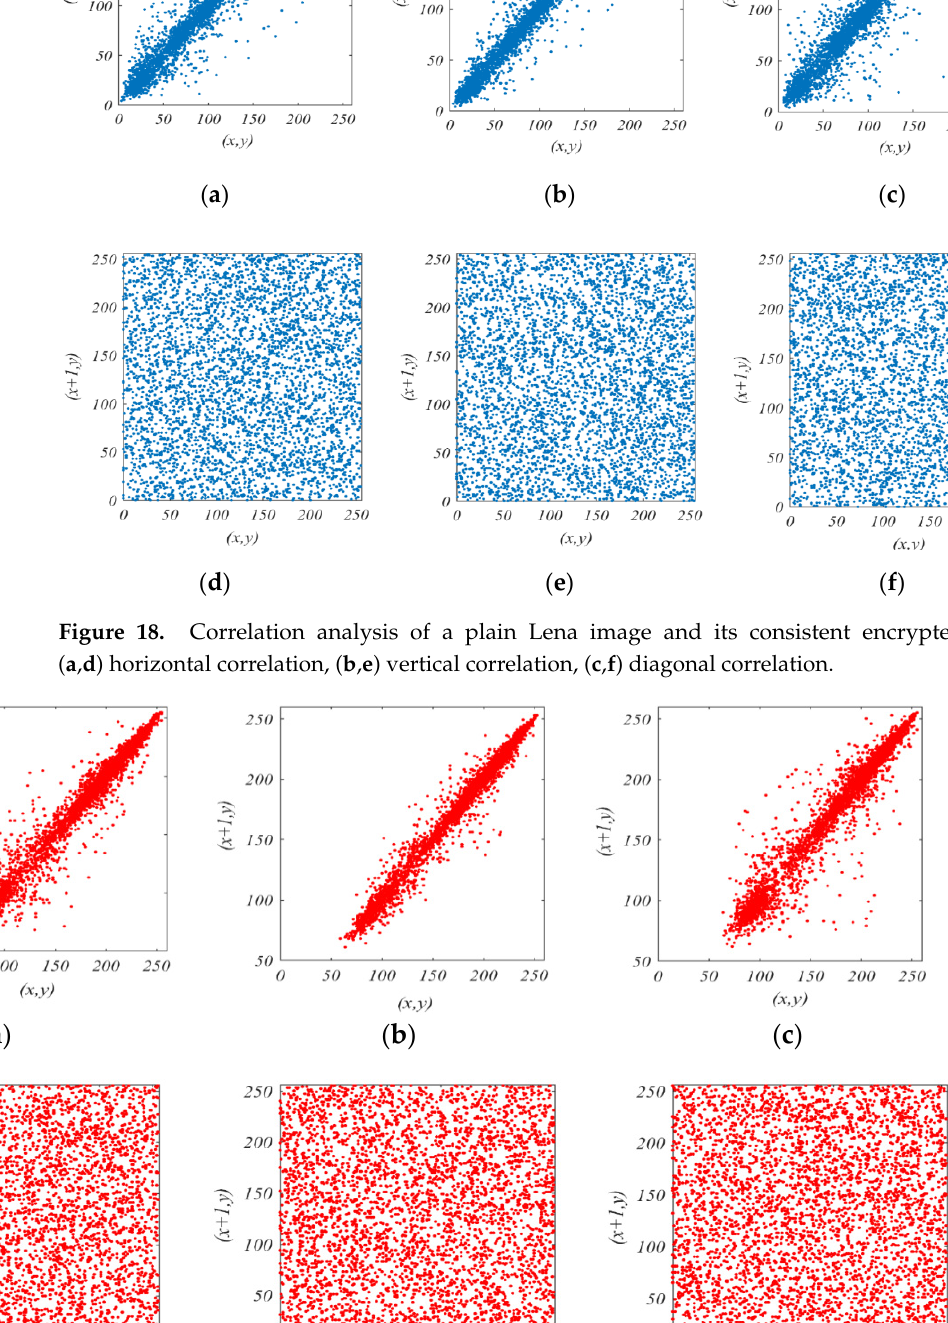
Figure 19. Correlation analysis of the R band of a plain Lena image and its consistent encrypted image: ( a , d ) horizontal correlation, ( b , e ) vertical correlation, ( c , f ) diagonal correlation.